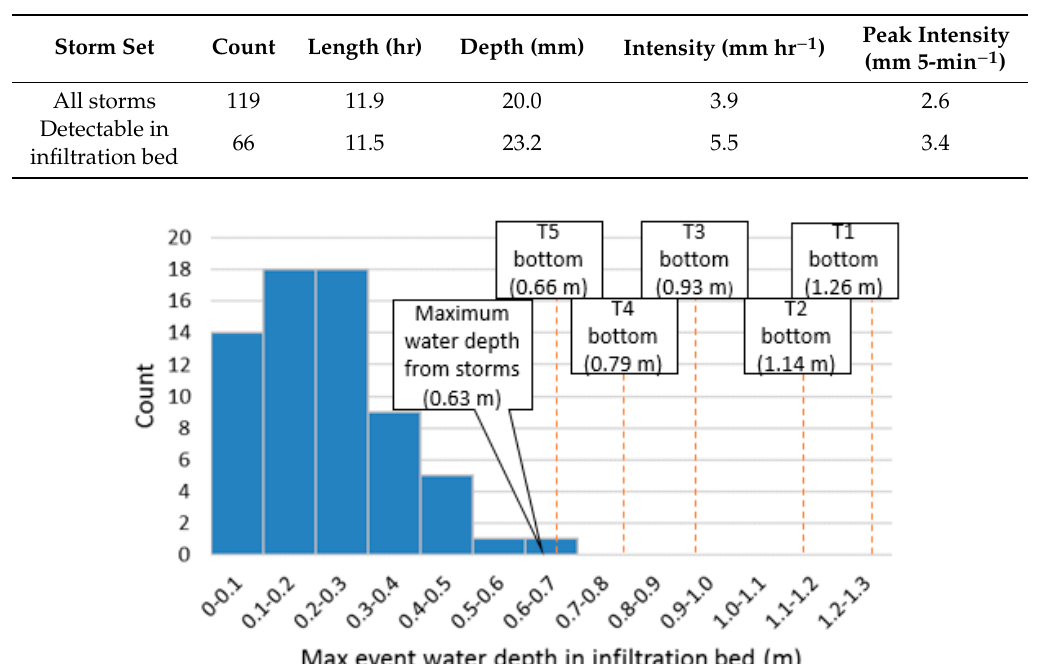
Figure 3. Distribution of the maximum event water depth (natural storms only) in the tree trench’s infiltration bed between March 2015 and April infiltration bed between March 2015 and April 2018.